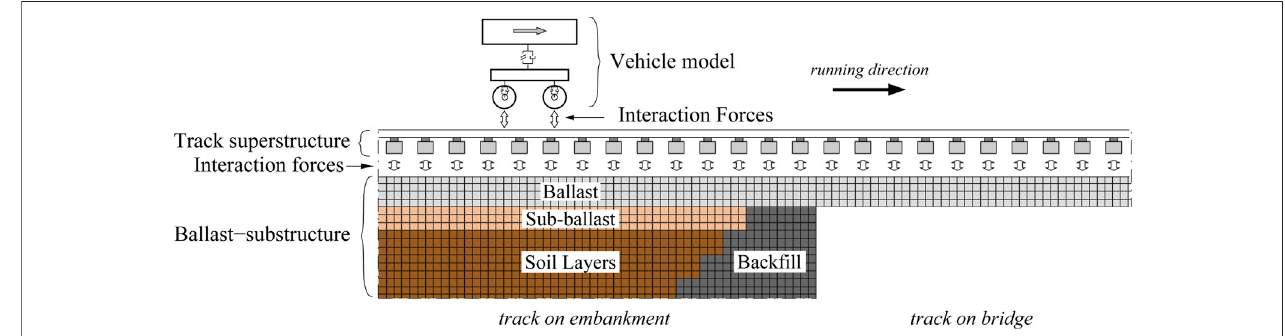
FIGURE 1 | Schematic representation of the 3D FEM model in longitudinal view (after (Varandas et al., 2014a)).